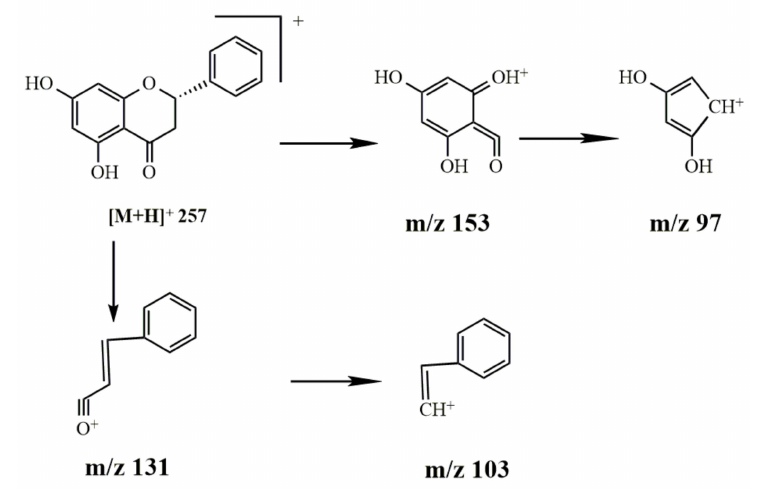
Figure 11. The cleavage pathway of